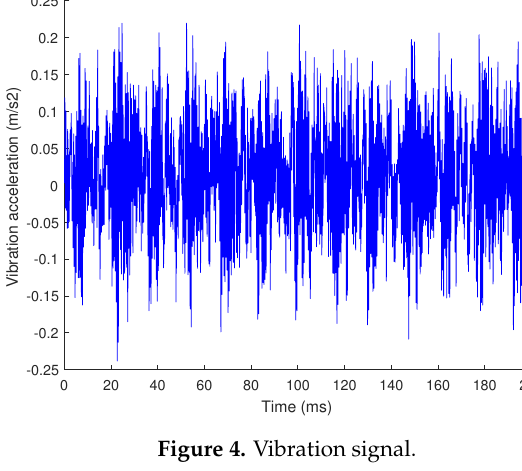
Figure 4. Vibration signal.